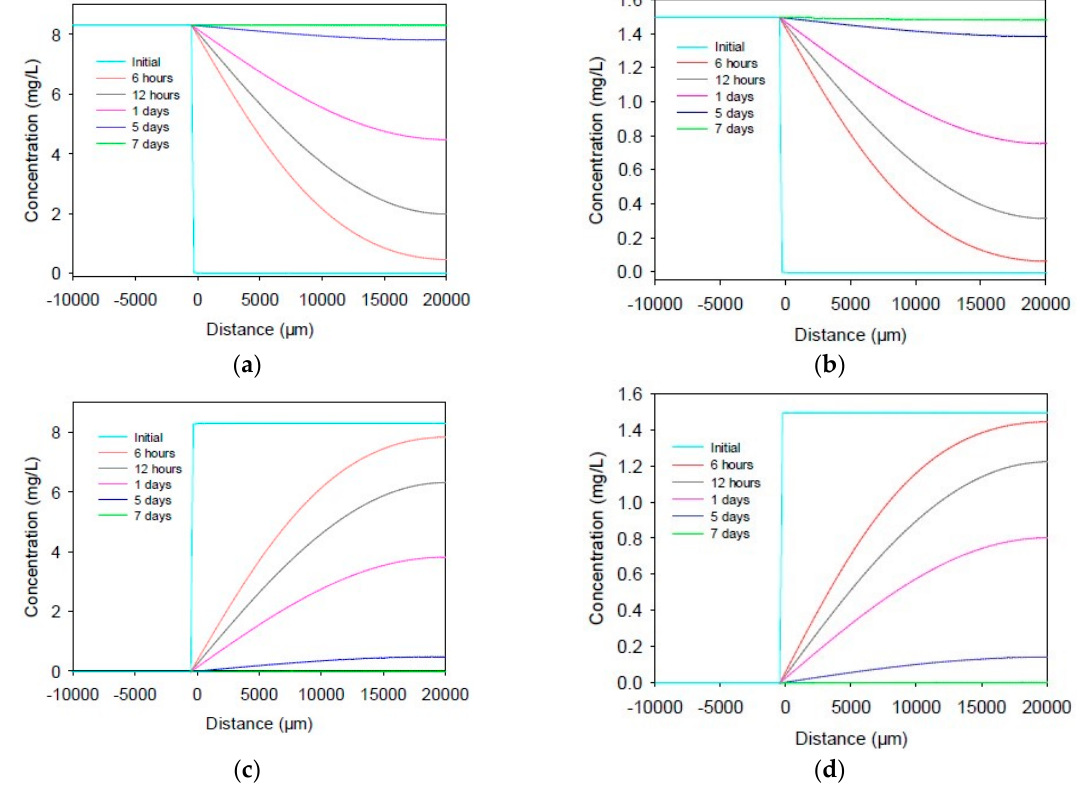
Figure 3. Simulated time required for diffusion into the sediment: (a) DO; and ( b ) NH 4+ -N and NO 3 − N. Simulated time required for diffusion out of the sediment: ( c ) DO; and ( d ) NH 4+ -N and NO 3 − -N .